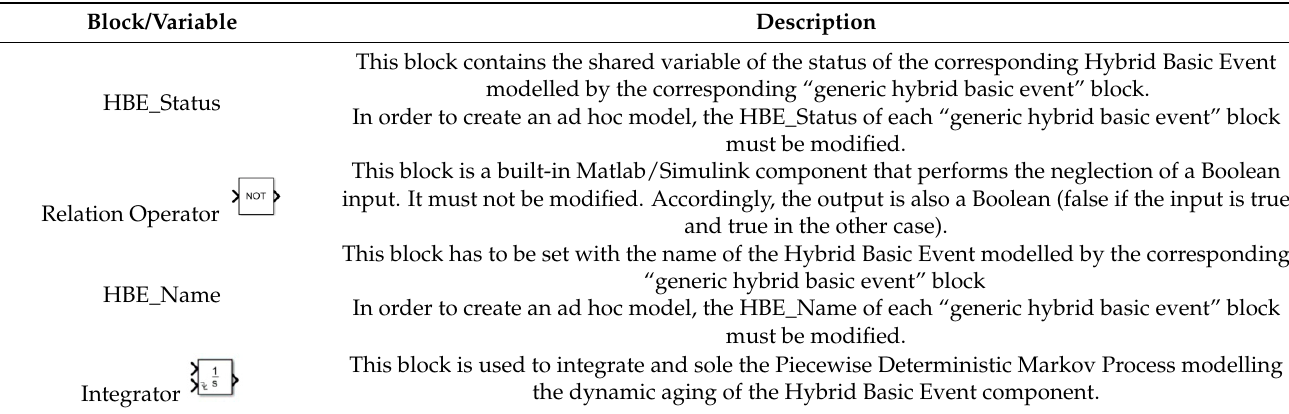
Table 4. Main elements of the “generic hybrid basic event” block.